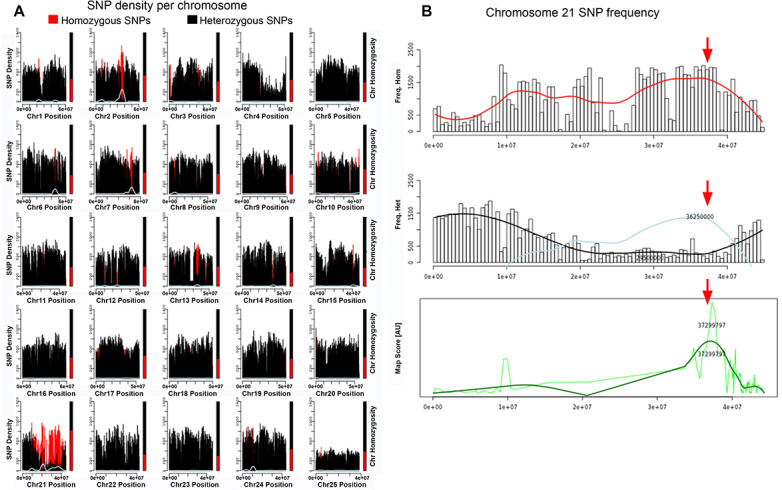
Mapping of SNPs linked to sagd1.(A, B) Homozygosity mapping showing chromosomal distributions of homozygous (red) and heterozygous (black) SNPs identified by whole genome sequencing of bulked DNA from 50 homozygous sagd1- / - mutants. (A) Homozygous SNPs are most abundant on Chromosome 21. Blue lines show local regression (LOESS) curves of homozygous-to-heterozygous ratios. (B) SNP densities and best fit for maximum homozygosity and minimum heterozygosity were used to plot map scores along chromosome 21. The location of pgk1 (red arrow) lies near the peak map score.